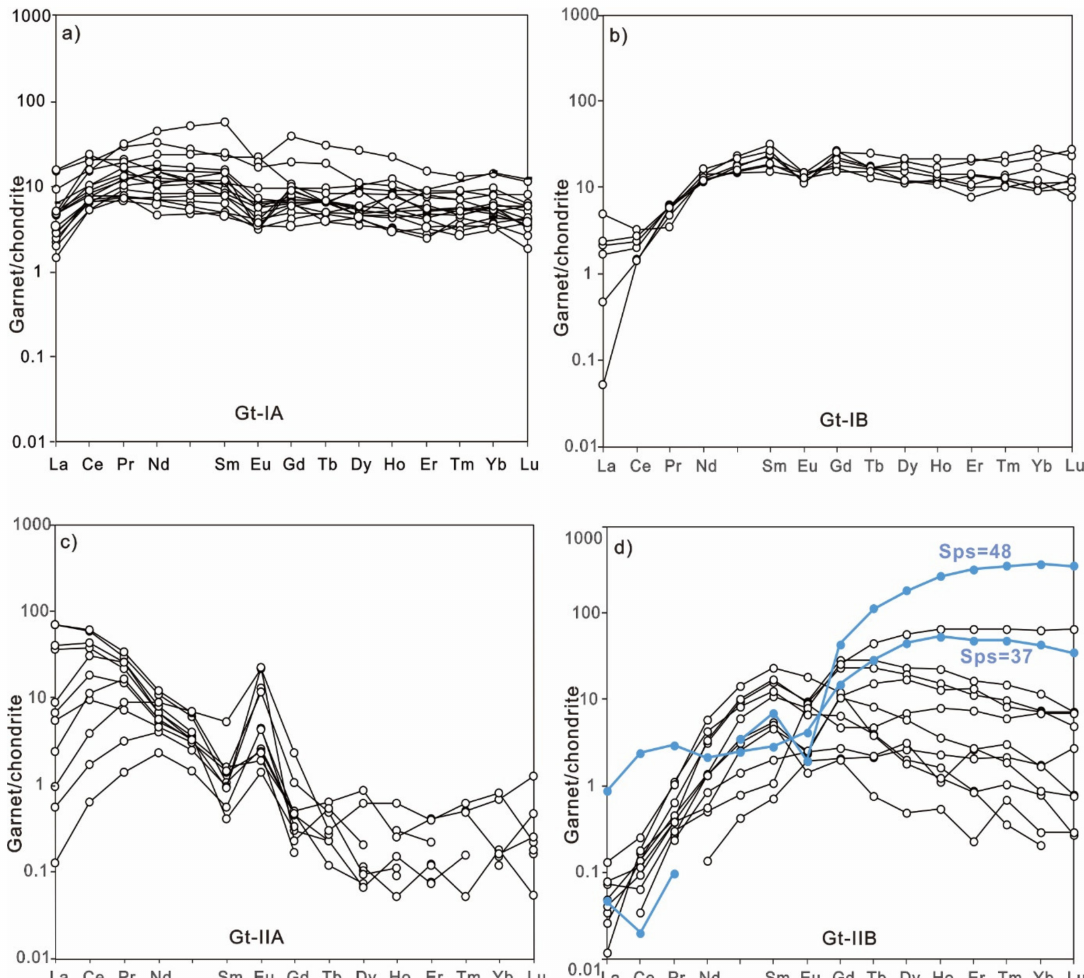
Figure 7. Chondrite-normalized REE patterns of the garnets from the Zhuxiling W (Mo) deposit, chondrite values from [31]. ( a – d ) shows REE patterns of Gt-IA, Gt-IB, Gt-IIA and Gt-IIB